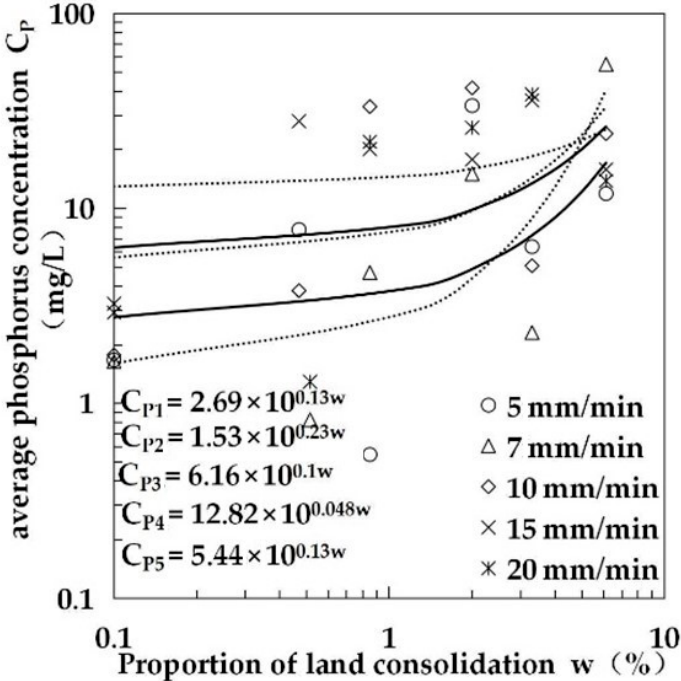
Figure 30. Changes in average phosphorus concentration at the outlet with land consolidation proportion under different rainfall intensities. Table 5. Changes in the small watershed erosion and transport parameters and the recommended consolidation